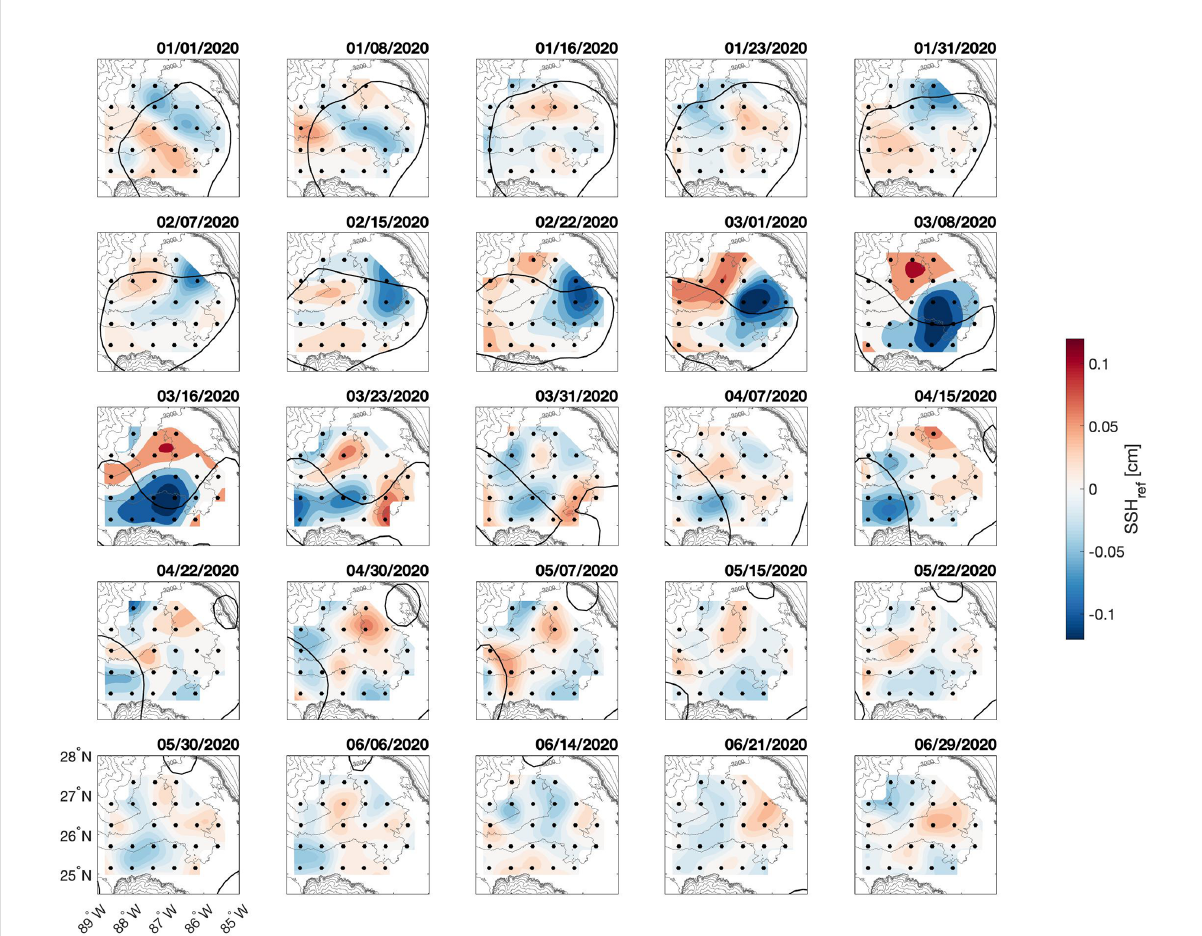
FIGURE 2 Mapped deep pressure fi elds, SSH ref , at seven to eight-day intervals during LCE Thor shedding event, January-June 2020. The bold SSH contour represents the location of the LC. CPIES locations are marked by black circles and bathymetry is contoured in light gray every 250